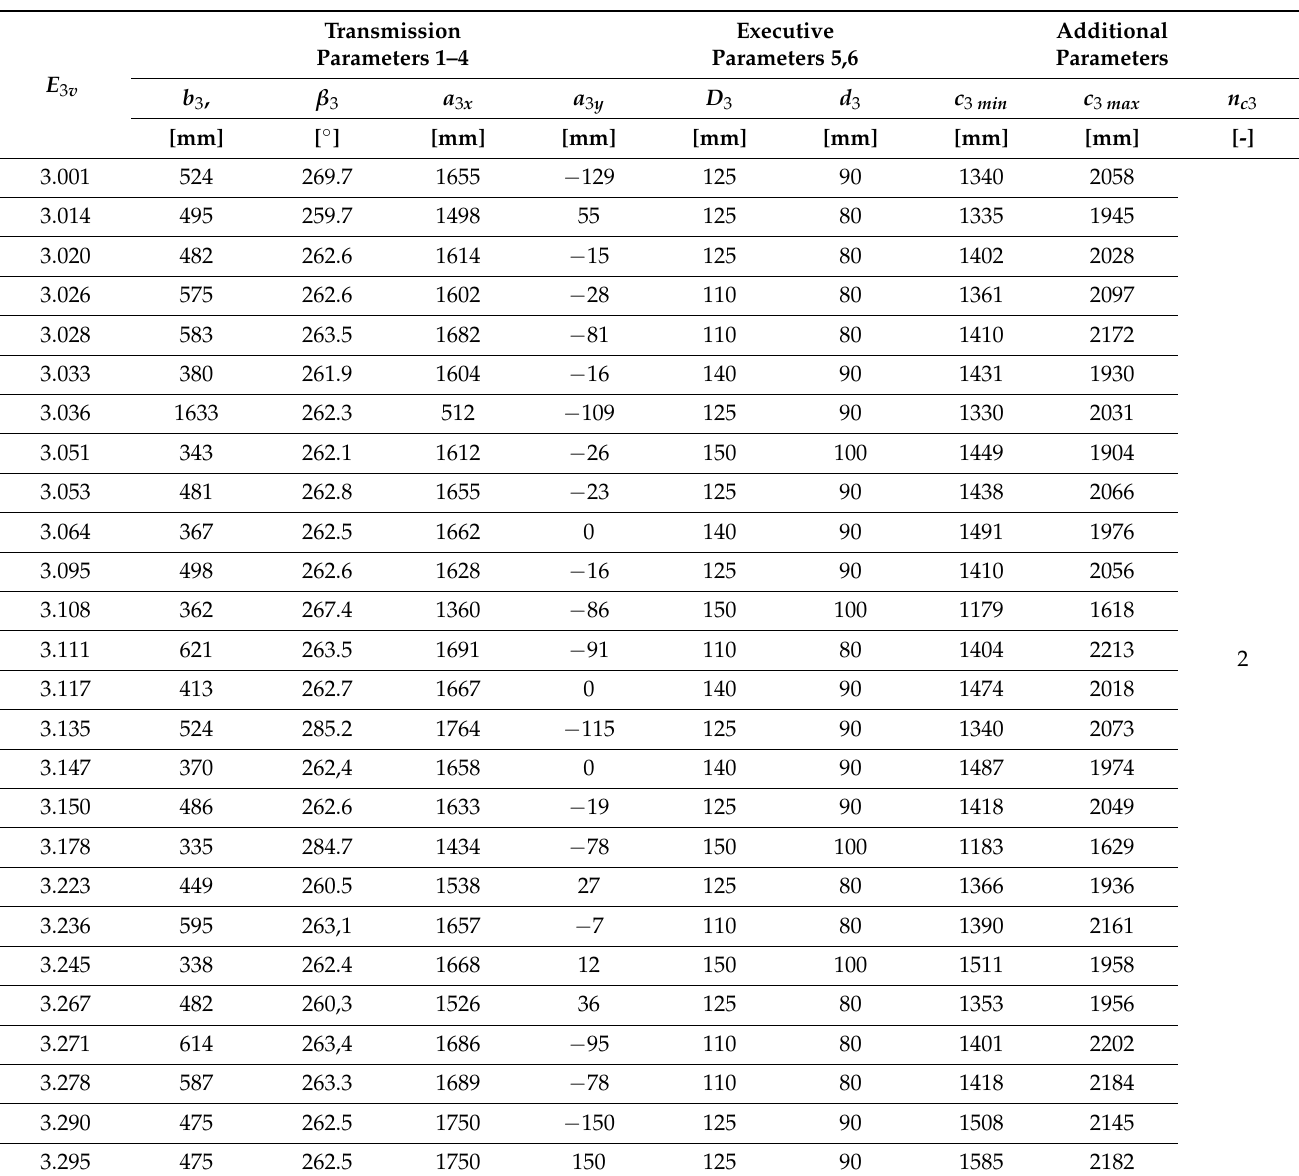
Table 1. Variant solutions for the arm drive